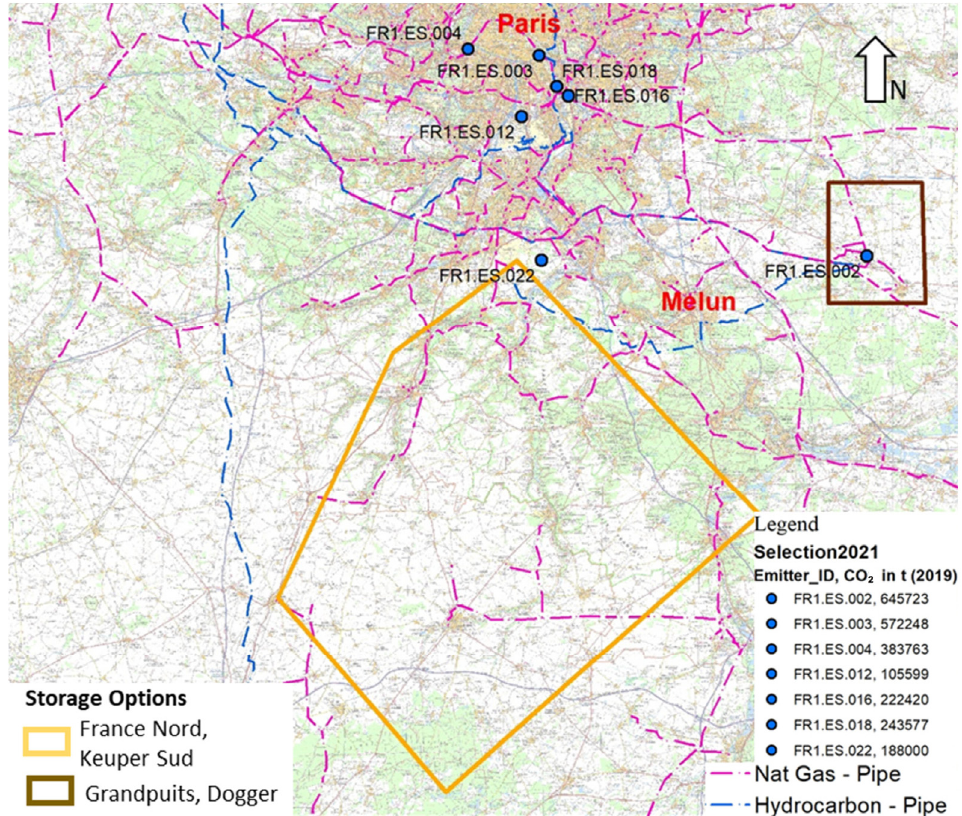
Figure 7. Storage options in both potential geological formations of the Paris Basin: the Keuper Fm. studied in the France Nord project and the Dogger Fm. at Grandpuits around the biggest CO 2 emitter of the region. Other CO 2 emission sources are also indicated by blue dots. These other sources are waste-to-energy facilities.